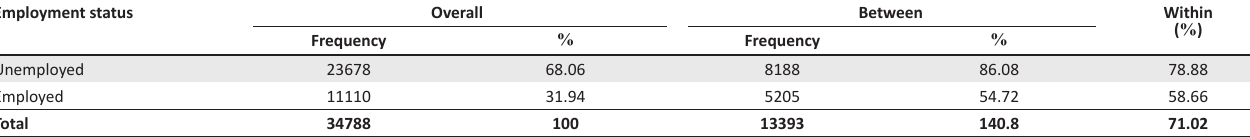
TABLE 4: Employment panel tabulation.